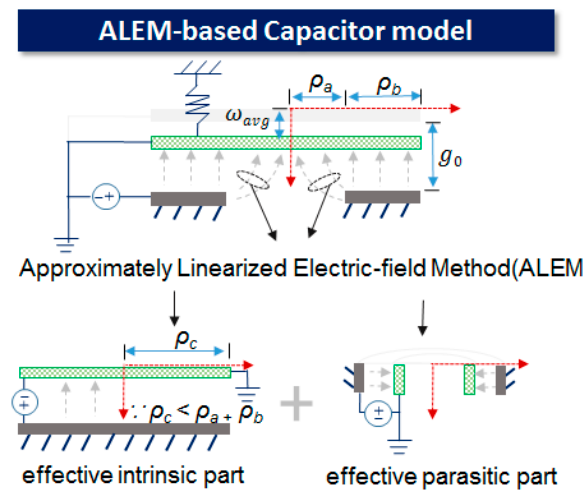
Figure 1. Schematic diagrams of a capacitive-type MEMS acoustic sensor for the explanation of a unit cell model which can be divided into an inner part and an outer part.